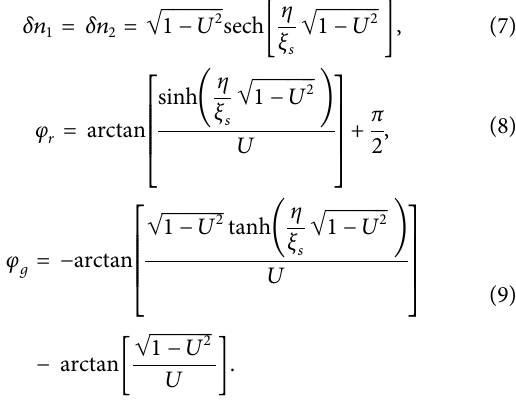
hump in the other, whereas n 1 + n 2 ≡ n 0 is constant, i.e., it is magnetic polarization angle φ r and the global phase φ g vary simultaneously in space (see bottom panel of Figure 2B ): φ r always jumps by π across φ − lim φ (cid:1) π , regardless of soliton velocity. In the soliton, lim r r η → + ∞ η → − ∞ contrast, the phase jump of φ g is velocity dependent, with the maximum shift − π only for stationary case.